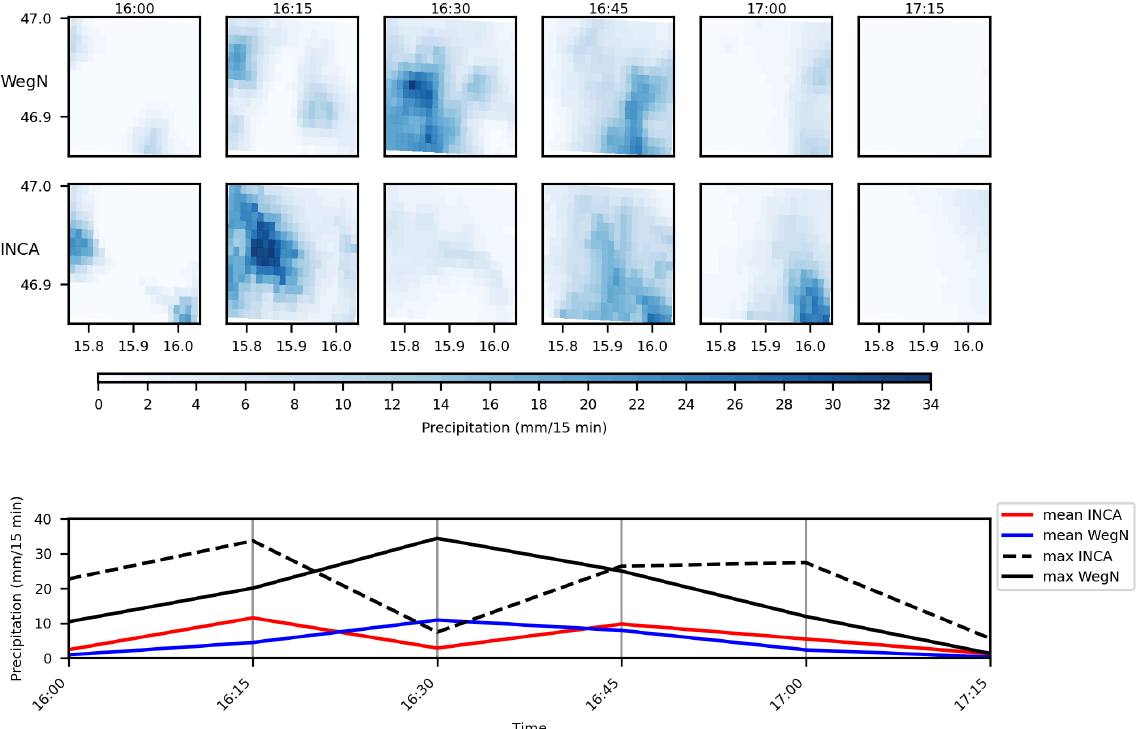
Figure 12. An event on 1 September 2011 in WegenerNet (top) and INCA (center) and time series of area-mean and maximum values in INCA and WegenerNet